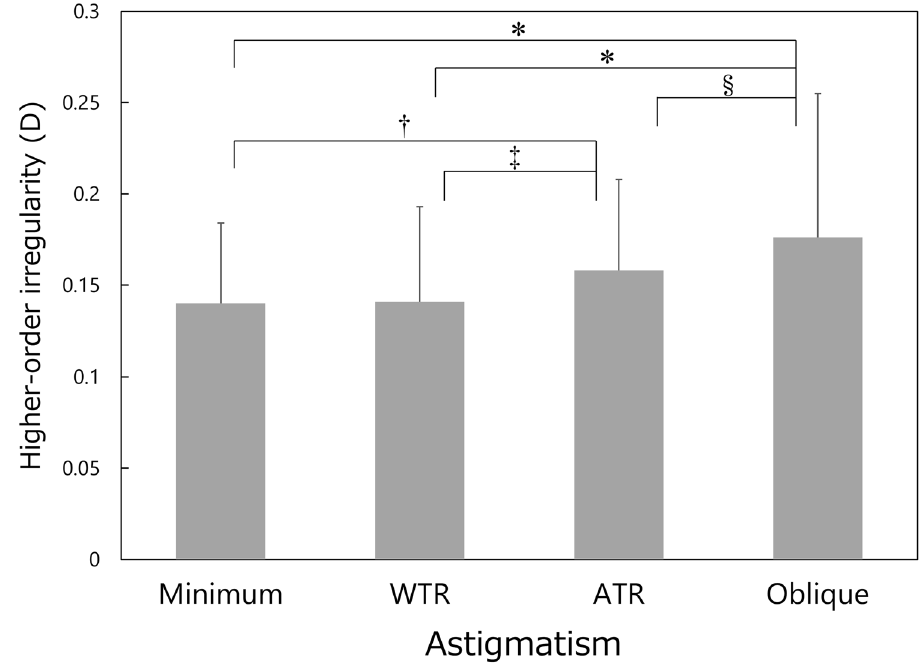
Figure 3. Comparison of higher-order irregularity component among the four types of corneal regular astigmatism groups. Mean ± standard deviation, WTR with-the-rule, ATR against-the-rule, * P < 0.001, † P = 0.009, ‡ P = 0.044, § P =